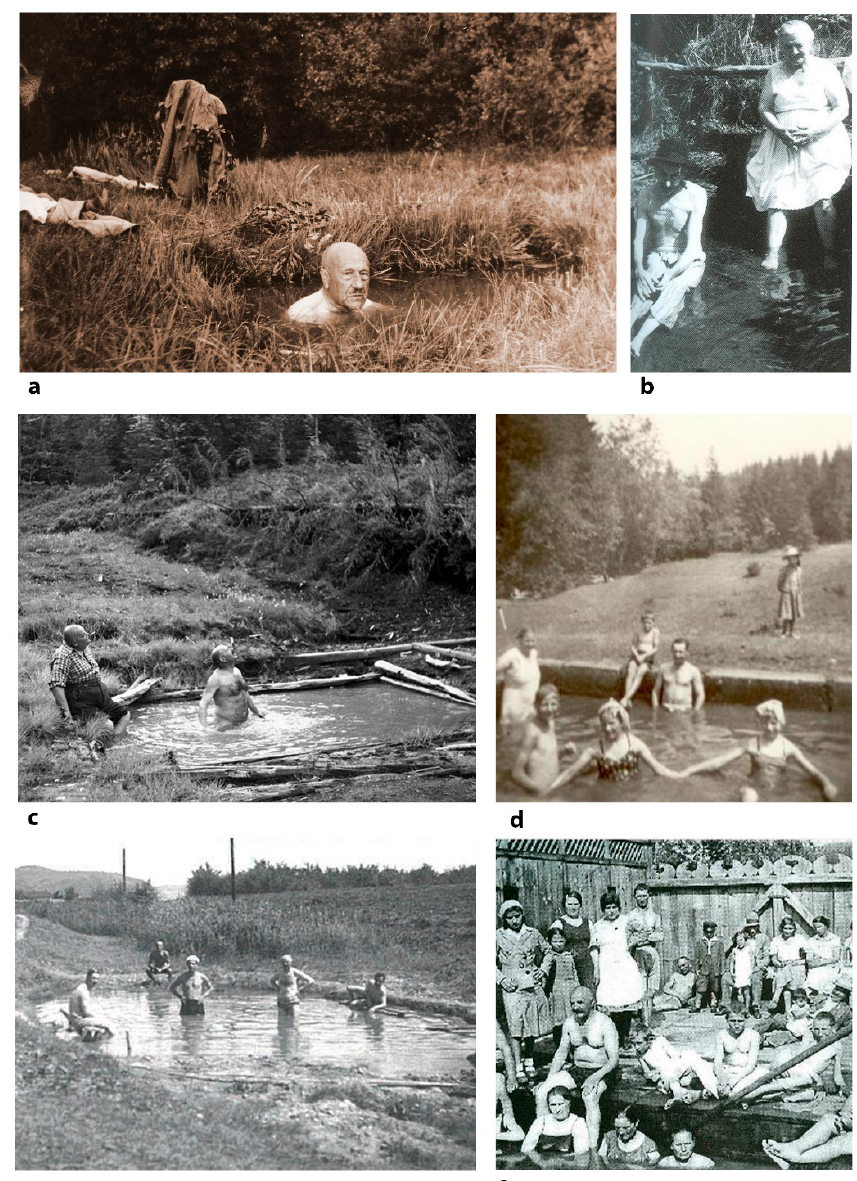
Figure 5. Use of traditional mineral baths by local people at the end of 19th century and first part of the 20th century: ( a , b )—Nádasfürd ő (Source: Ars Topia Foundation); ( c )—Torja (source: photo collection of Szkler National Museum Sepsiszentgyörgy); ( d )—Kirulyfürd ő (source: private collection of Csaba Jánosi); ( e )—Sósfürd ő , Székelyudvarhely (source: Vofkori György [56]); ( f )—Homoródfürd ő (source: private photo collection of Márton Balázs).